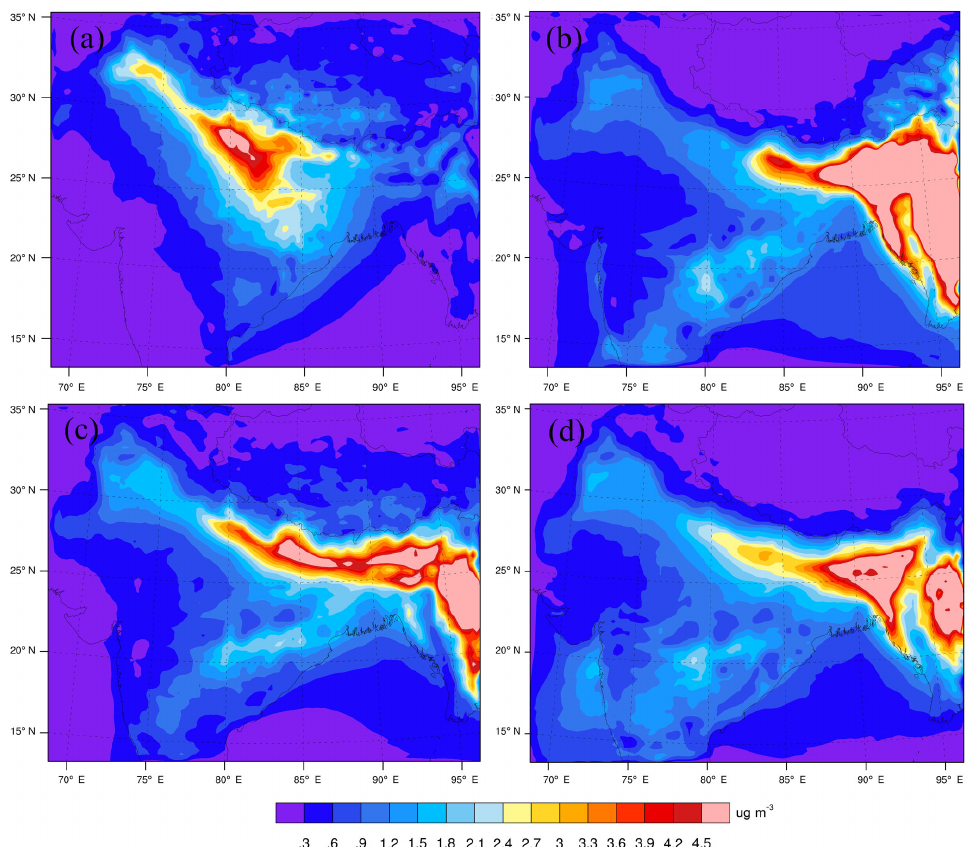
Figure 8. Mean BC concentration simulated by WRF-Chem model at QOMS and its vicinities: (a) event A; (b) event B; (c) event C; (d) event